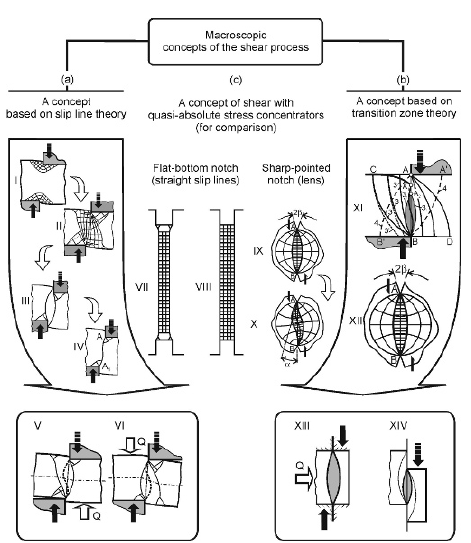
Figure 1. Macroscopic concepts of shear process: a) shear stages according to slip line theory (I-IV) and effect of clamp Q on shape of slip velocity discontinuity line as likely fracture trajectory (V-VI); b) shear stages according to transition zone theory (XI-XIV); c) distribution of slip lines for shear with flat (VII-VIII) and sharp-pointed (IX-X) stress concen- trator. Based on [1] and